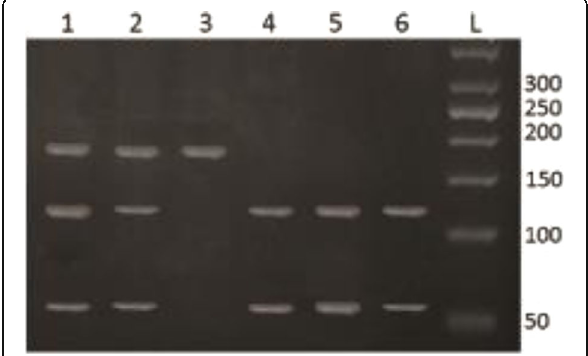
Fig. 2 Agarose gel electrophoresis of GSTO2*N142D (rs156697) SNP RPFP-PCR products. Lanes 1 and 2: heterozygous mutant genotype G/A (185 bp, 122 bp, 63 bp). Lane 3: homozygous wild genotype A/A (185 bp). Lanes 4, 5, and 6: homozygous mutant genotype